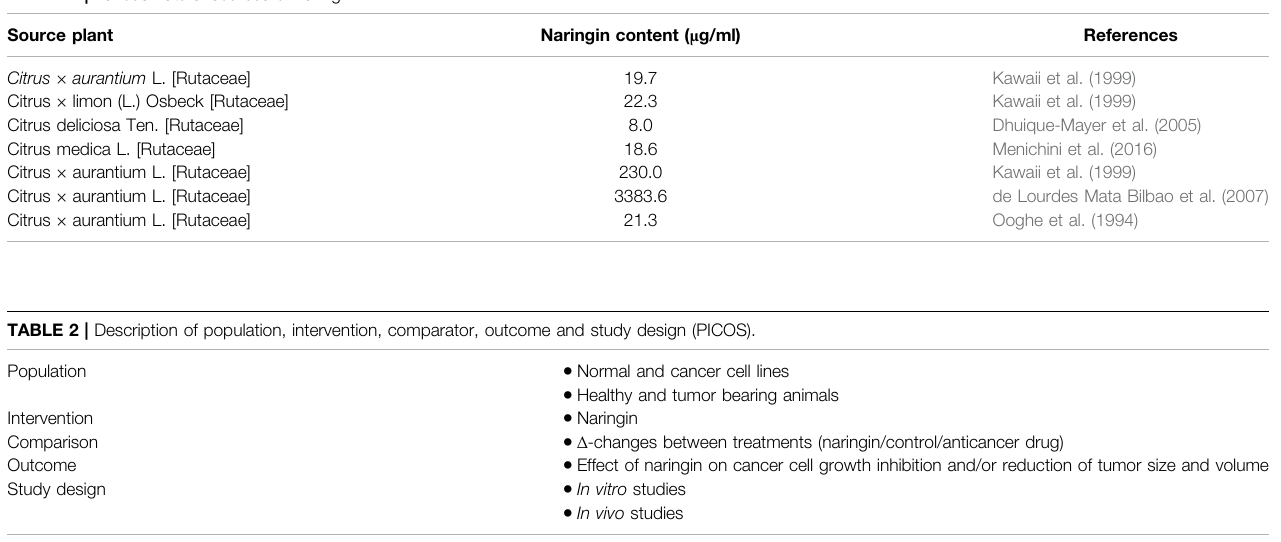
TABLE 1 | Various natural sources of naringin.